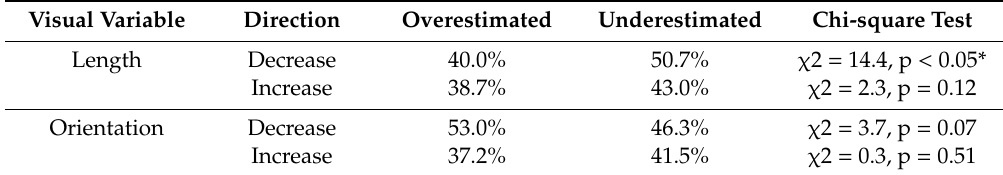
Table 1. Chi-square tests for perception bias. Significant di ff erences are indicated by an asterisk